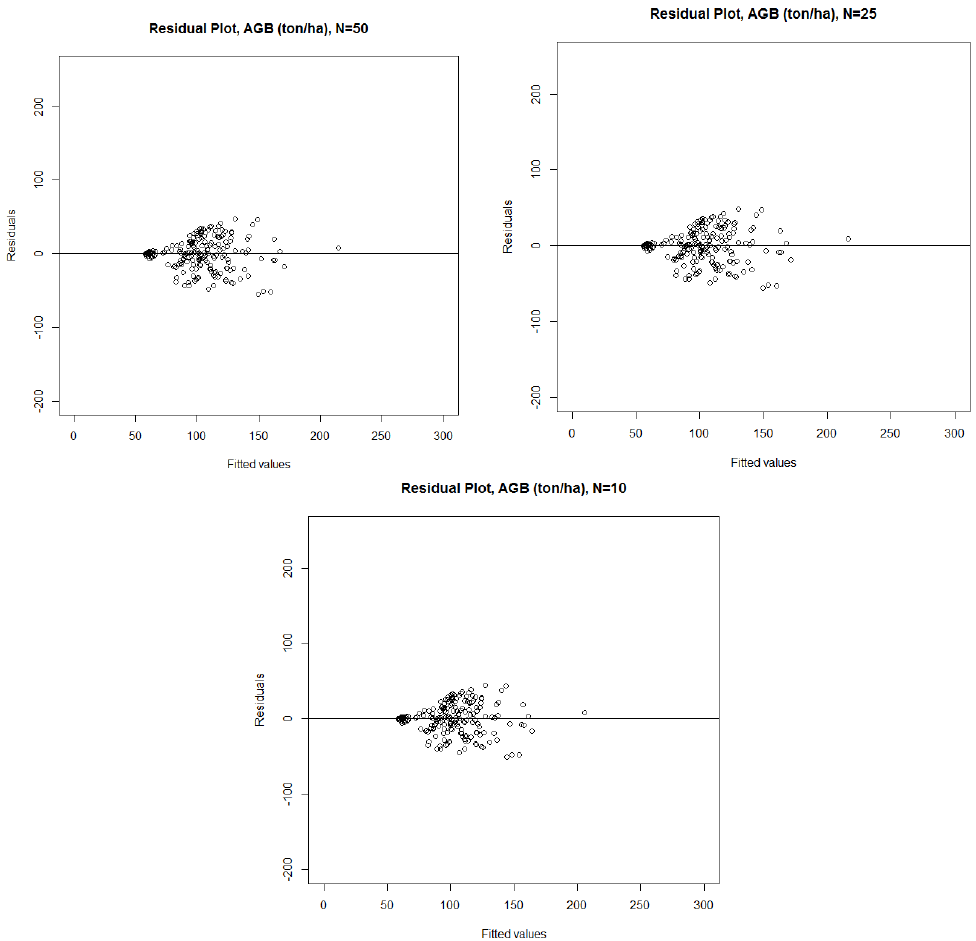
Figure 6. The residuals plots of RapidEye for AGB at phase